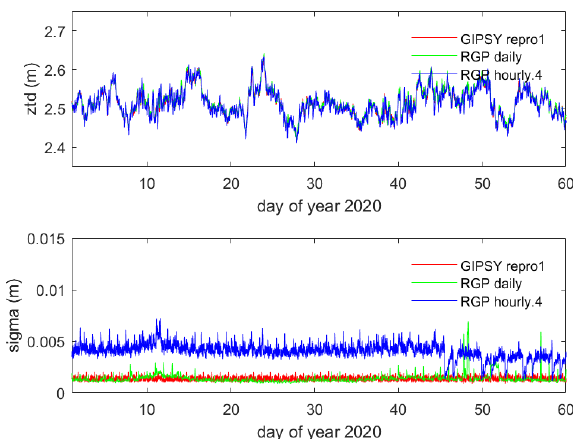
Figure 3. Time series of ZTD estimates and formal errors ( σ ) from RGP NRT.4, RGP daily, and GIPSY repro1 solutions from 1 Jan-